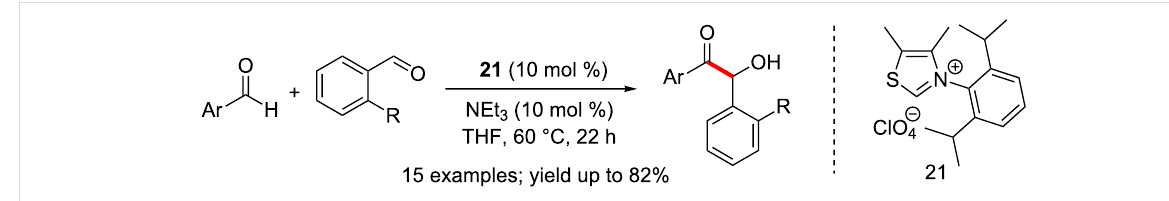
Scheme 10: Chemoselective cross-benzoin reactions catalysed by a bulky